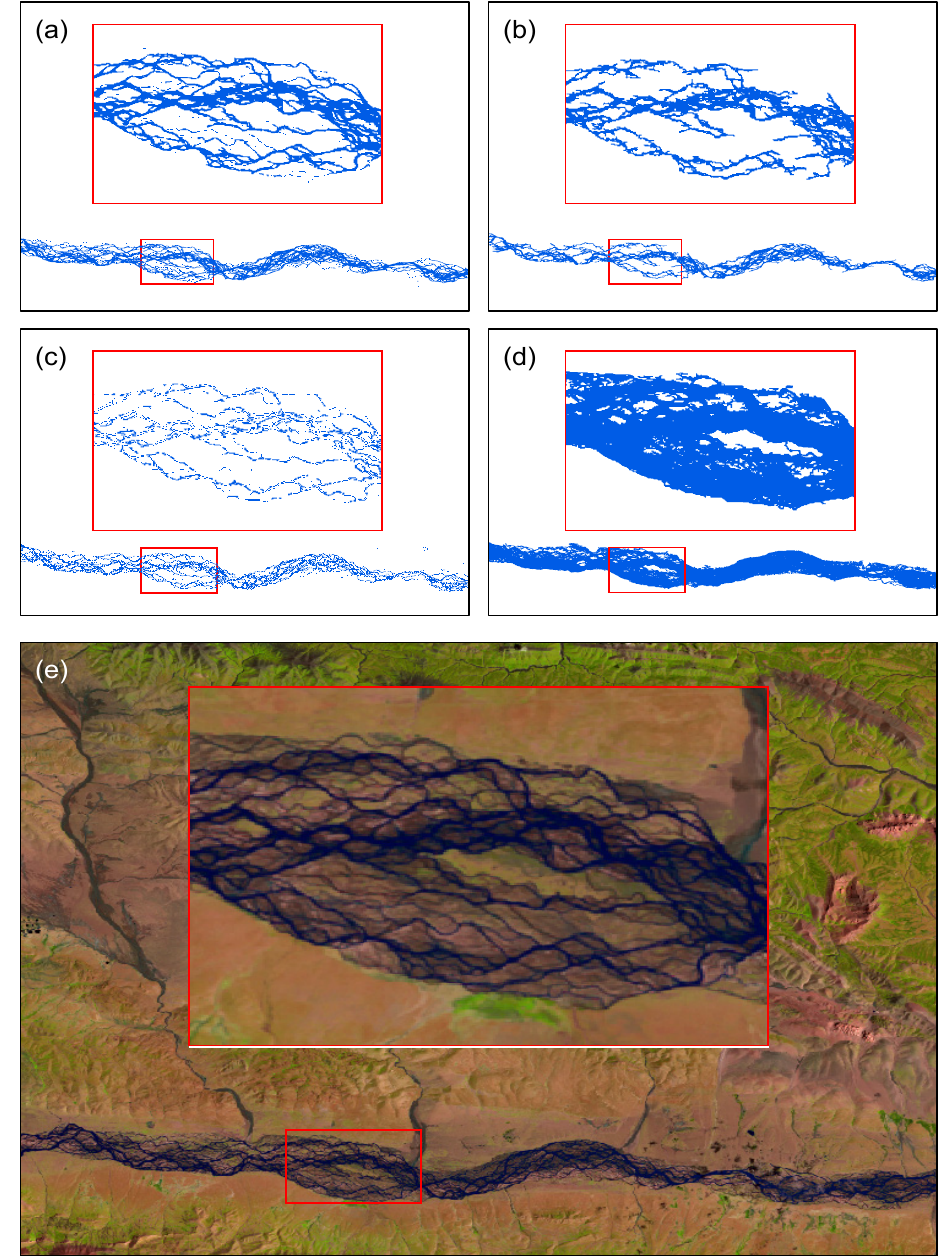
Figure 5. Comparison of water bodies for a part of braided reach A extracted from Landsat images in 1990 using different methods: ( a ) the combined method, ( b ) the JRC dataset, ( c ) NDVI , ( d ) EVI . ( e ) The original Landsat image for a part of reach A on 18 May 1990 with an enlarged view of a local braided reach.